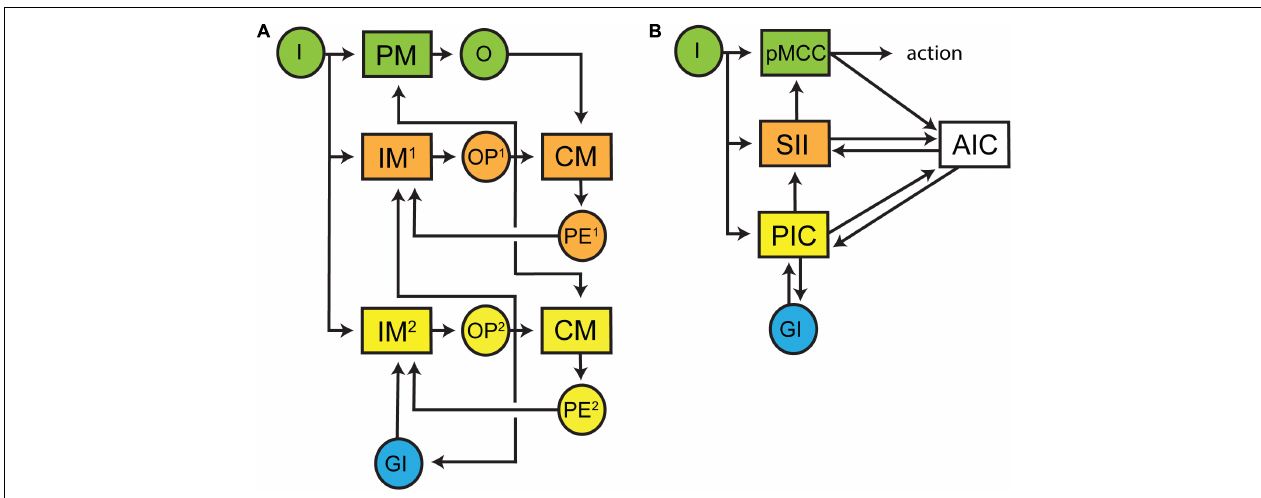
FIGURE 3 | Schematic diagrams of the proposed minimal architectural framework underpinning subjective experience. (A) The overall flow of neural processing is represented in three tiers. The sensory processing pathway is coloured green and contains an input (I) into a processing module (PM) and an output (O) from that module. A monitoring circuit (an internal forward model, IM 1 ) receives a copy of I and outputs (OP 1 ) a prediction of O. OP 1 and O are compared by a comparator module (CM) and a prediction error (PE 1 ) is generated and then fed back to IM 1 to update its model. A second monitoring circuit (coloured yellow) controls the first monitoring circuit (coloured orange). The second internal forward model (IM 2 ) receives input form I and global input (GI) from other processing modules and generates a prediction (OP 2 ) of OP 1 . OP 2 is compared against OP 1 in a CM and the prediction error (PE 2 ) is fed back into IM 2 to update its model. OP 2 is also broadcast globally to update other processing modules. (B) The framework presented in panel (A) can be mapped on to cortical regions processing noxious inputs. Inputs initially enter the posterior mid-cingulate cortex and generate descending motor outputs. These motor outputs are also relayed to the anterior insular cortex where they are compared with predictions arising from tiered forward models located in the somatosensory area II and posterior insular cortices. These predictions hierarchically descend on to the posterior mid-cingulate cortex where they modulate motor outputs. Feedback (prediction errors) from the anterior insular cortex to both the somatosensory II and posterior insular cortices maintain the accuracy of predictions. The posterior insular cortex predictions are further modulated by reciprocal connections with multiple cortical areas processing other sensory